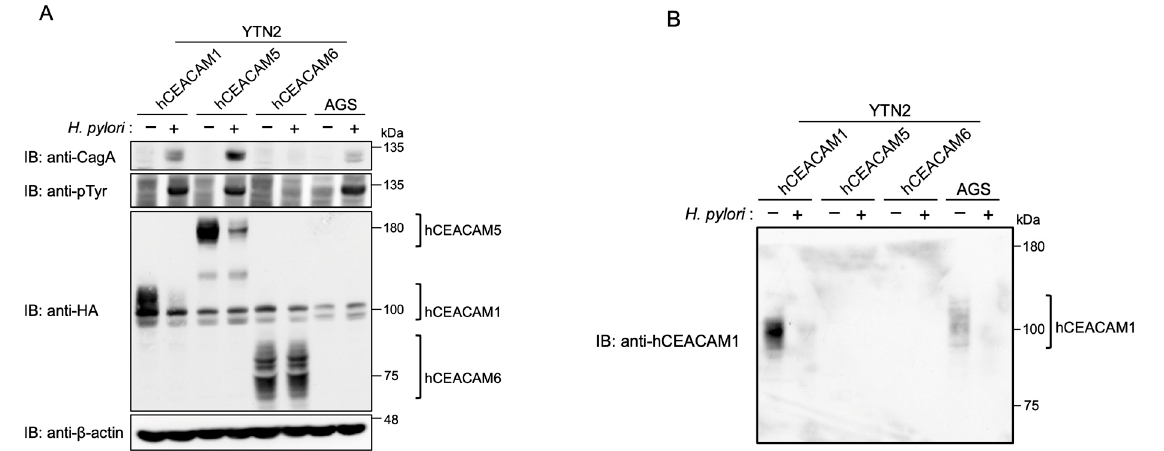
Figure 4. Infection with cagA -positive H. pylori is capable of delivering CagA into mouse gastric epithelial cells expressing human CEACAM. YTN2 cell-derived hemagglutinin (HA)-tagged human CEACAM1 (hCEACAM1), human CECAM5 (hCEACAM5), and human CEACAM6 (hCEACAM6) stable cells and AGS cells were infected with H. pylori NCTC11637 for 7 h at a MOI of 100. The cells were harvested and analyzed for CagA, tyrosine phosphorylation (pTyr) of CagA, and HA-tagged CEACAM proteins. The broad bands represent heavily glycosylated bands of CEACAMs ( A ). The anti-HA membrane was reprobed with an antihuman CEACAM1 ( B ). Experiments were carried out in biological duplicates ( n = 2) and the representative images are shown. See also Supplementary Figures S3–S5.